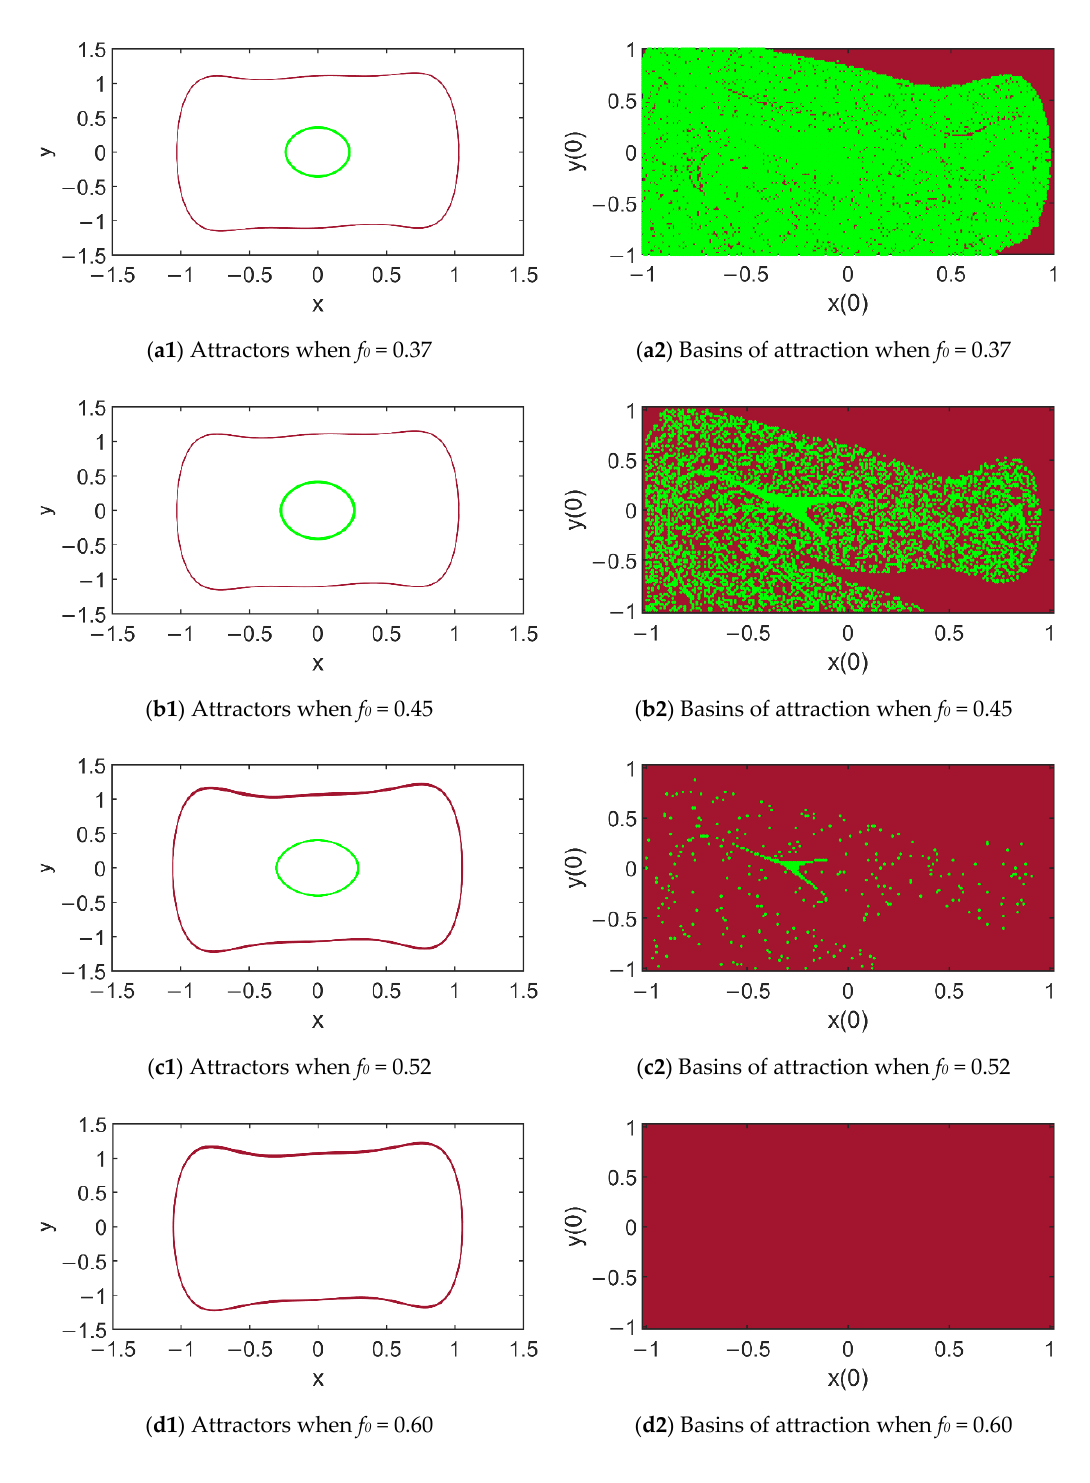
0 ranging from 0.37 to